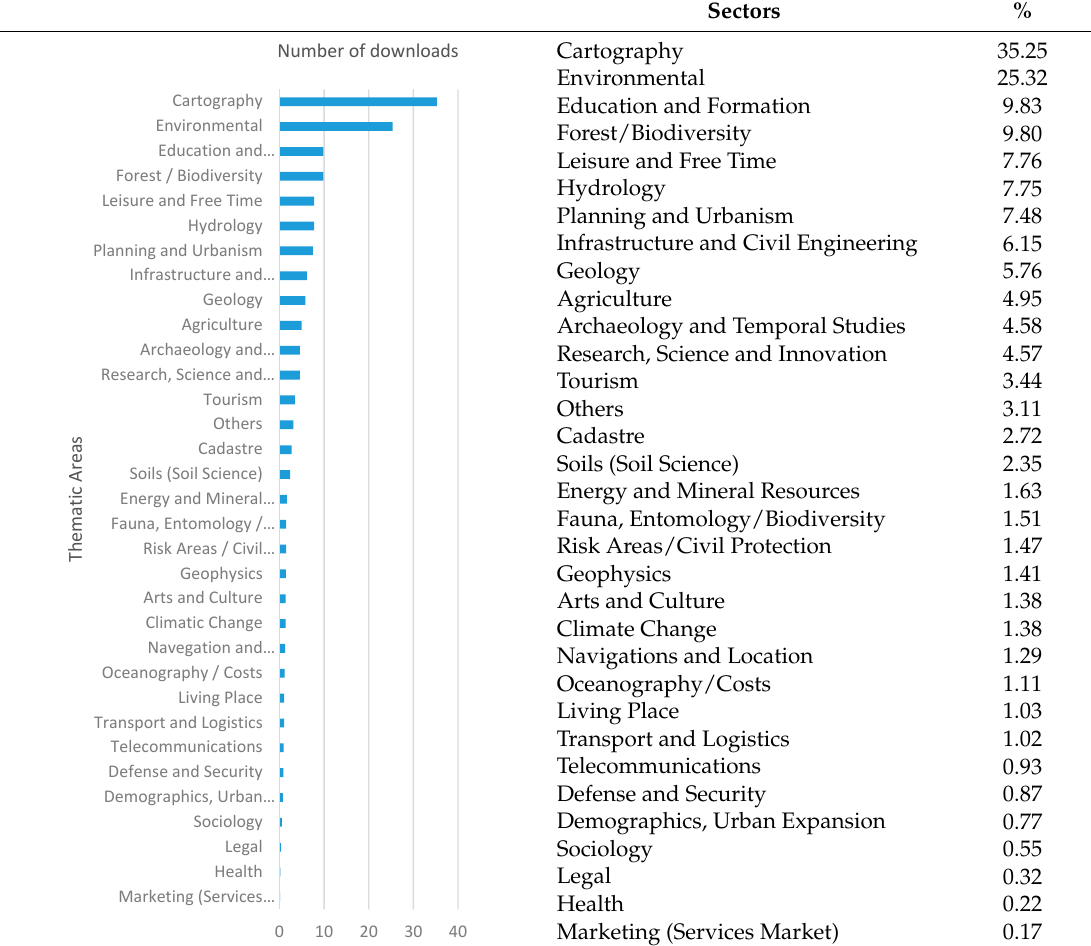
Table 7. Percentage of downloads in each of the Thematic Areas. (Sorted by percentage).